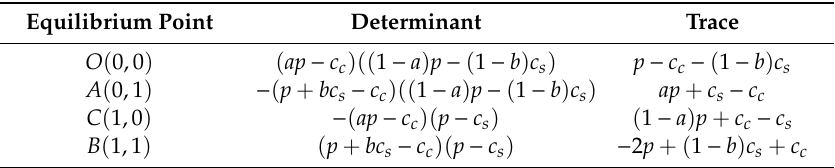
Table 2. The determinant and trace of equilibrium